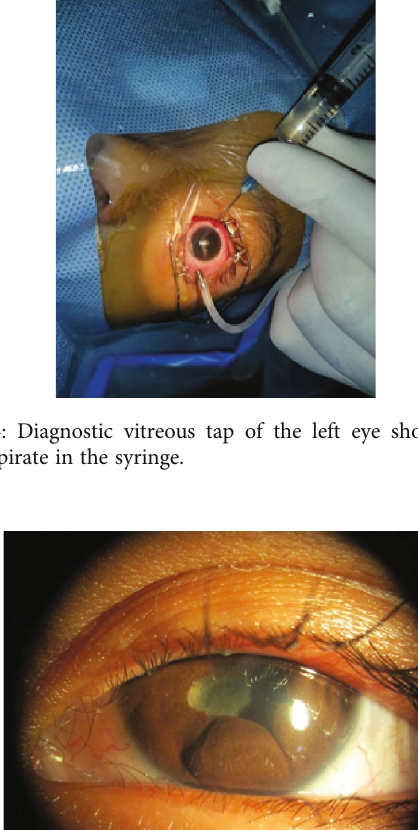
Figure 2: Slit view of the left eye showing an exudative clump in the middle of anterior chamber along with 1 mm cream colored settled hypopyon.